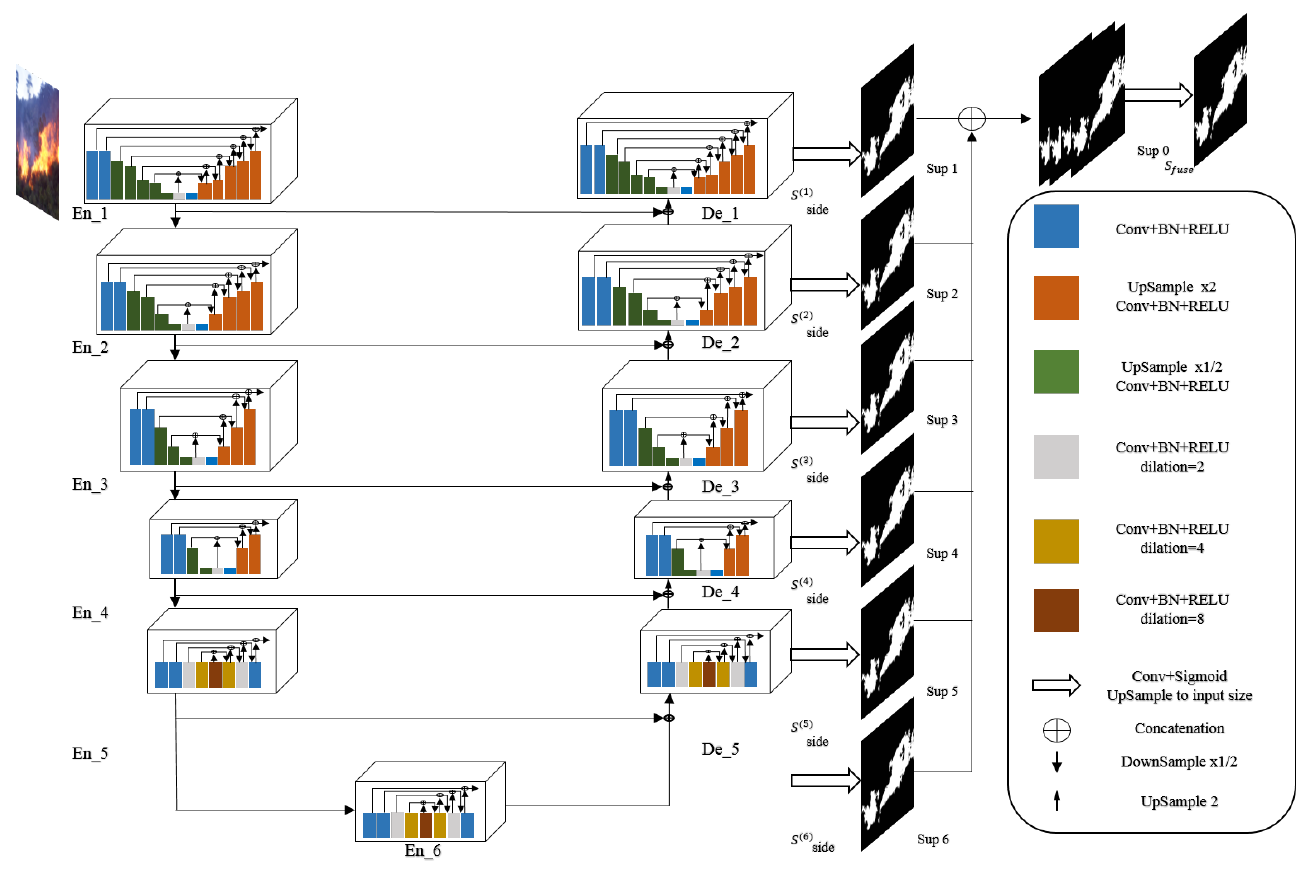
Figure 3. The proposed U 2 -Net